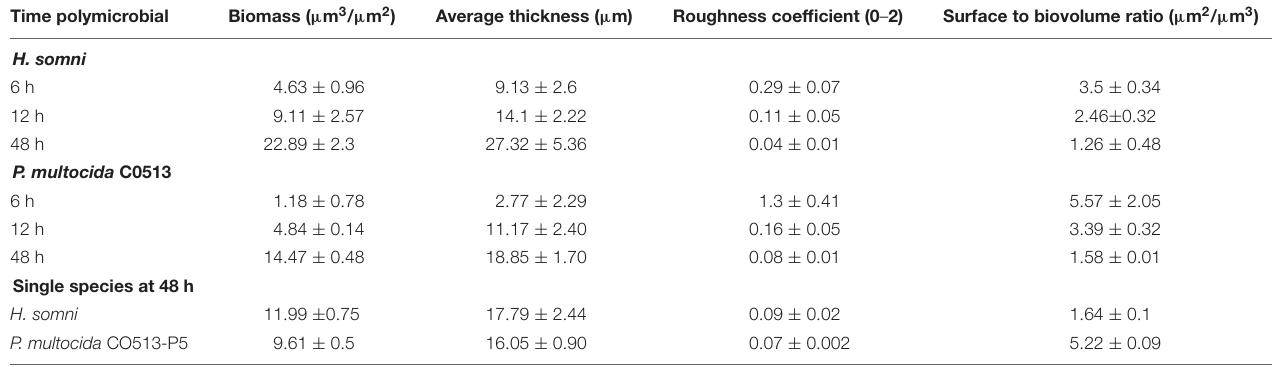
TABLE 1 | COMSTAT analysis of fluorescence in situ hybridization of polymicrobial and single species biofilms. a